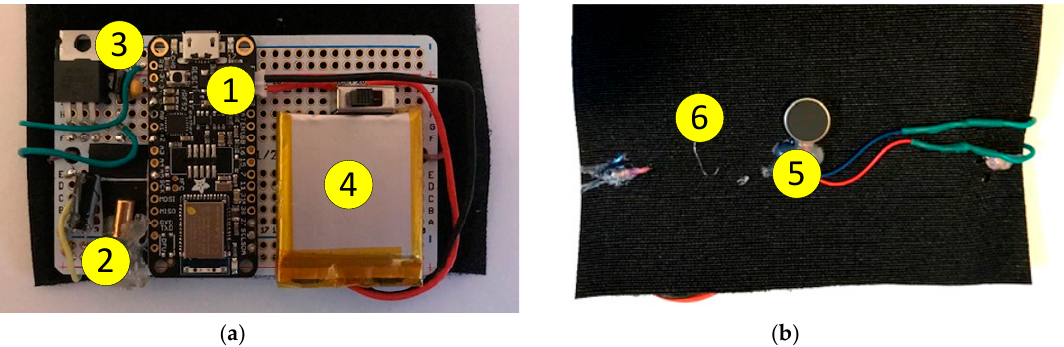
Figure 10. Photograph of the wearable gadget – ( a ) Top view: (1) SoC microcontroller with BLE and battery charger; (2) Tilt sensor; (3) MOSFET; (4) Li-Po rechargeable battery. ( b ) Bottom view: (5) Vibration motor; (6) Gadget sewed on loop style non-adhesive nylon strips fabric.